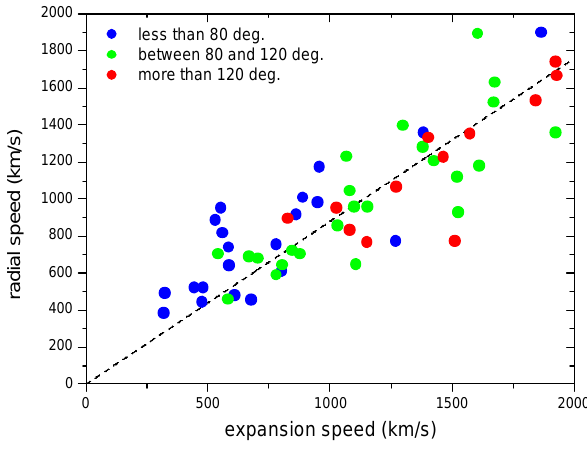
Fig. 7. The correlation between radial CME speed V rad and the Figure 7. The correlation between radial CME speed V rad and the lateral expansion speed V exp for lateral expansion speed V exp for limb CMEs observed by LASCO limb CMEs observed by LASCO between January 1997 and April 15, 2001. between January 1997 and 15 April